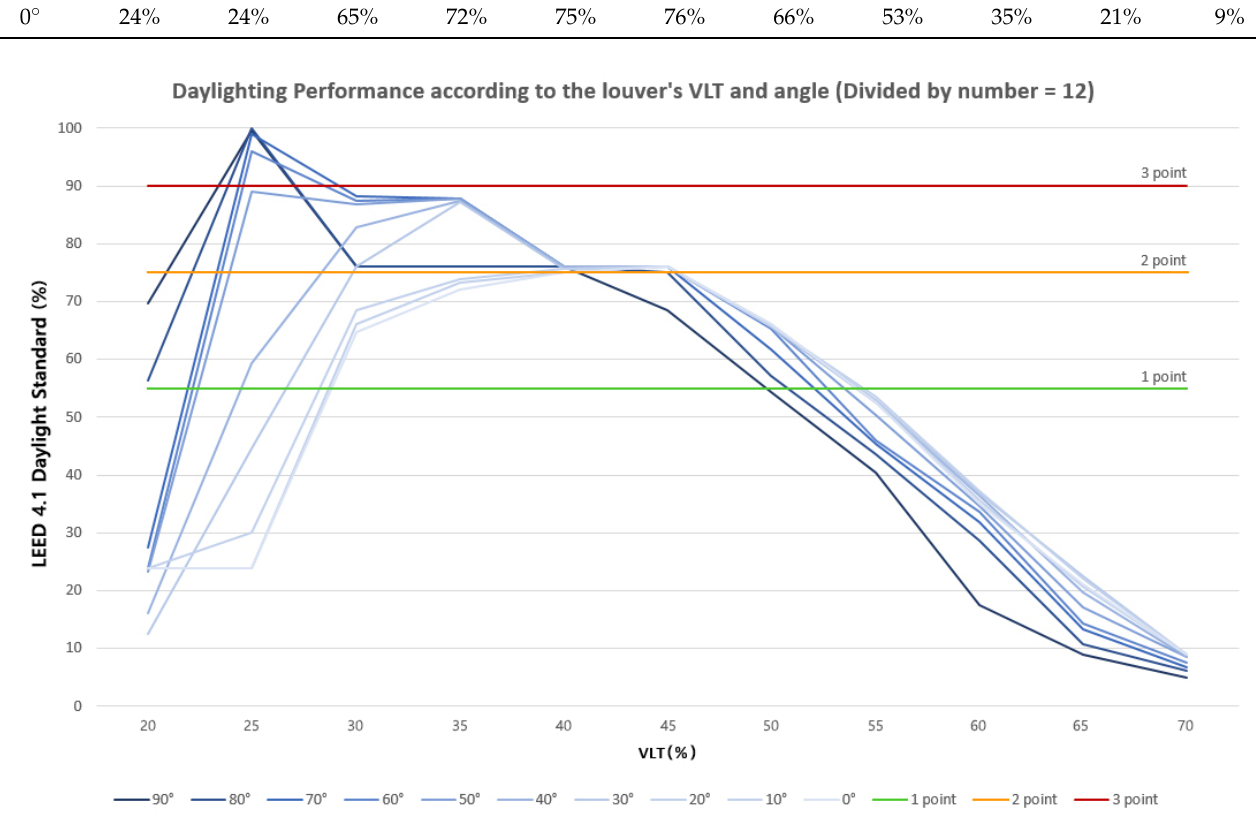
Figure 7. Target illuminance achievement rate graph when the number of divisions of louvers is 12. Table 7 and Figure 8 show target illuminance achievement rates when the number of louvers is 13. At VLT of 25%, 3 points could be obtained at 90 ◦ , 80 ◦ , 70 ◦ , and 60 ◦ , the same as when 11 or 12 louvers were available. There were 30 cases in which two points could be obtained. Therefore, the number of cases in which more than two points could be obtained was found to be